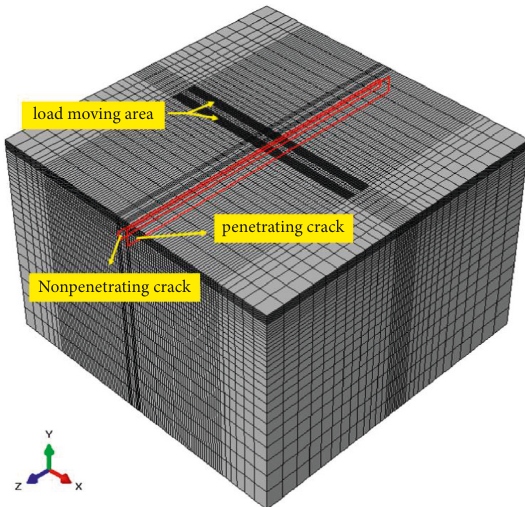
Figure 2: Finite element mesh of the pavement structure.